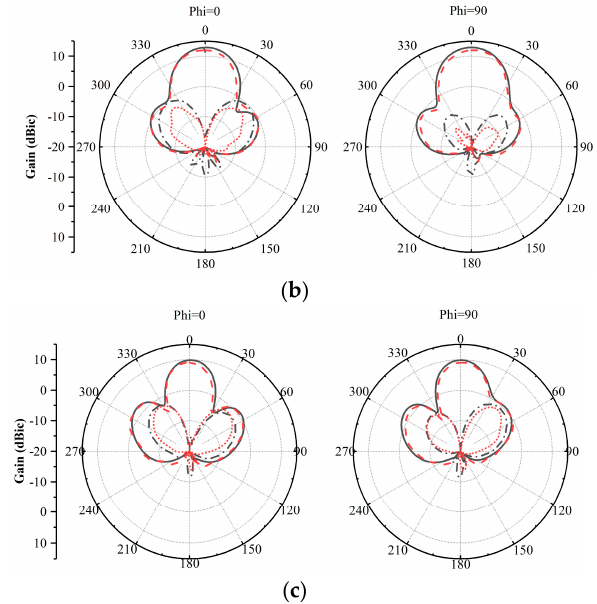
Figure 10. Simulated and measured radiation patterns of the proposed CP antenna. ( a ) 4.6 GHz. ( b ) 6.0 GHz. ( c ) 8.0 GHz. Table 1. Comparison between the proposed antenna and previous works.